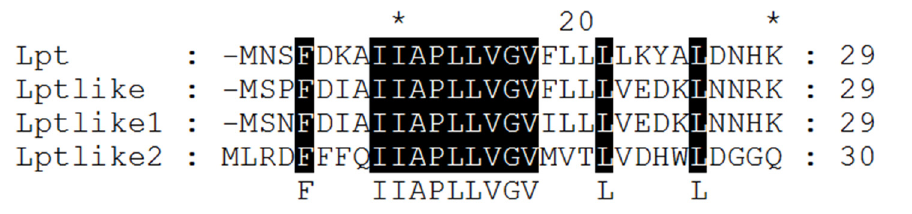
Figure 3. Multiple sequence alignment of the four different peptides identified in the analyzed strains. 244 * 10 bp intervals along with the sequence length